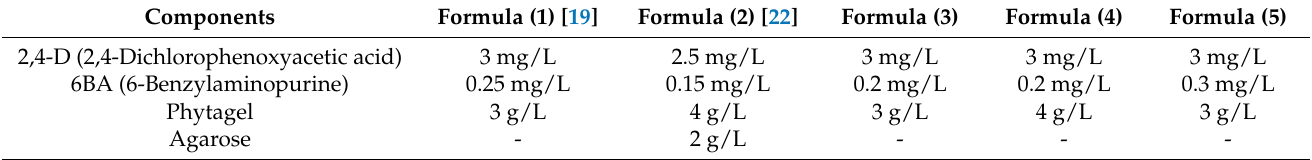
Table A1. Comparison of callus induction media with different cytokinin to auxin ratios.